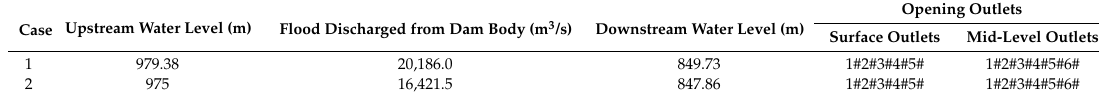
Table 2. Operating